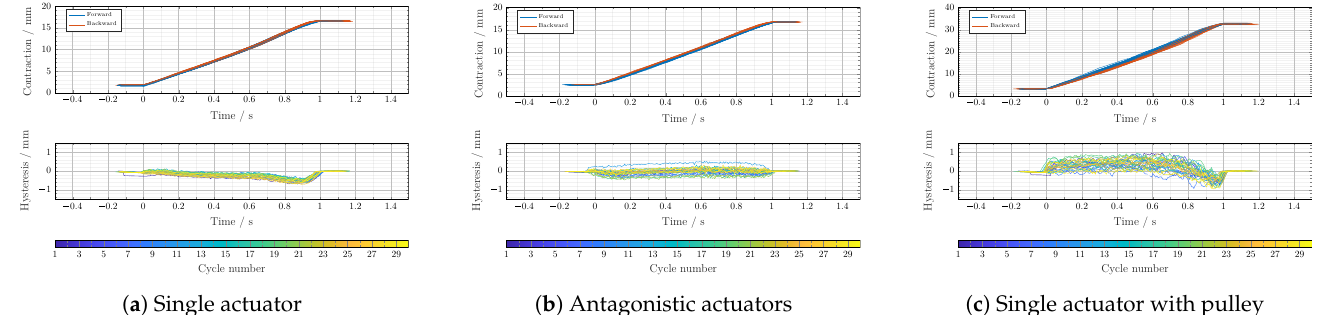
Figure 6. Hysteresis results for the tests moving between the limits of the operating